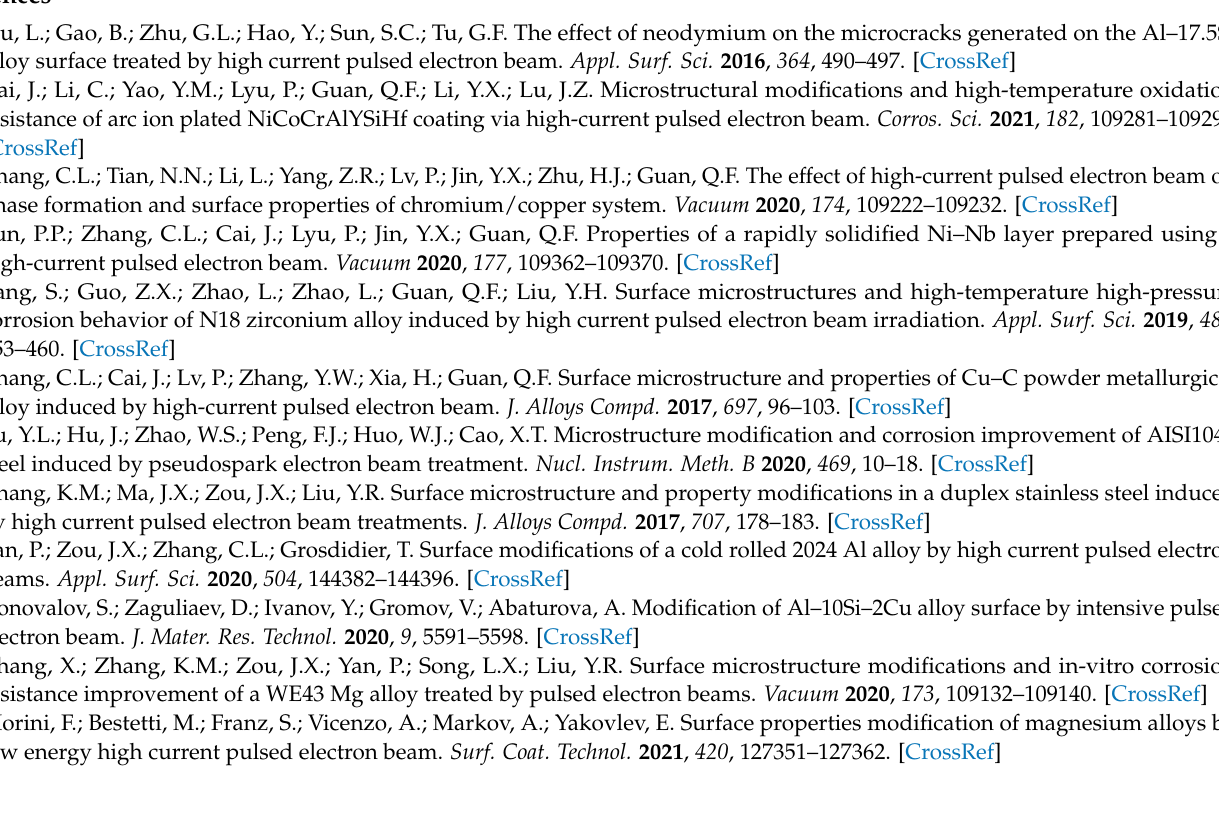
Figure S2: The SEM morphology micrographs of HCPEB-irradiated and HCPEB-unirradiated Al–20Si alloy surface. (a) Original specimen; (b) 5 pulse specimen, 27 kV and 4 J/cm 2 ; (c) 15 pulse specimen, 27 kV and 4 J/cm 2 ; (d) 25 pulse specimen, 27 kV and 4 J/cm 2 , Figure S3: The relationship between microcrack density and pulse number for Al–20Si and Al–20Si–0.3Nd alloy surfaces under HCPEB irradiation, Figure S4: The SEM morphology micrographs and relevant microcrack density for Al–20Si–5Mg–0.7Ce alloy surface irradiated by HCPEB at 24 kV and 2 J/cm 2 . (a) BSE image, 5 pulse specimen; (b) BSE image, 15 pulse specimen; (c) BSE image, 25 pulse specimen; (d) Relationship between microcrack density and pulse